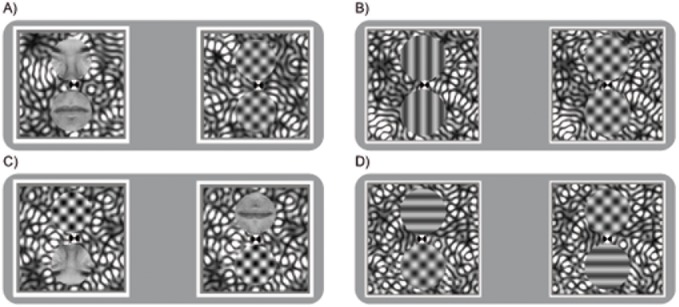
Schematic representation of the stimuli used in Experiment 2.Matching images were presented along the vertical meridian and could be presented to the same eye (A&B) or to different eyes (C&D). For the matching images we used upright (A) and inverted (C) faces, as well as vertical (B) and horizontal gratings (D). The surround was presented with either crossed or uncrossed disparity, resulting in the images being perceived as either being occluded by the surround or not.